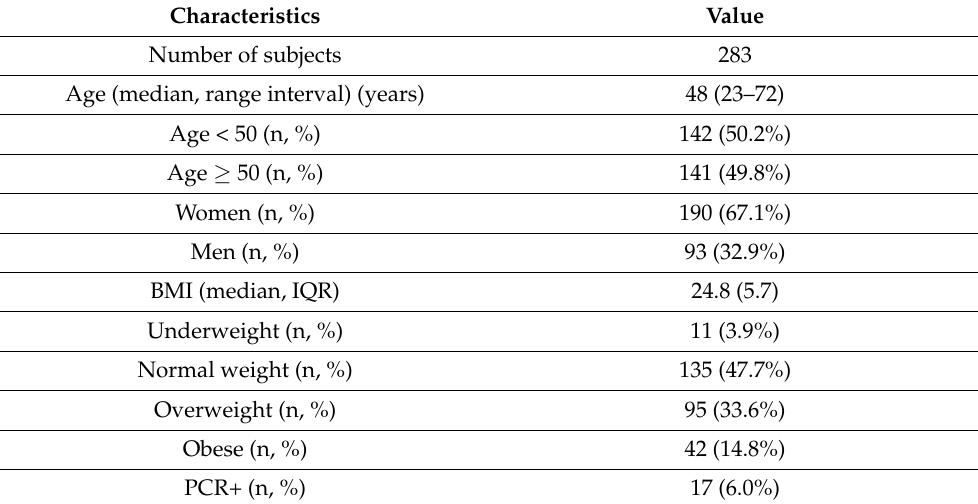
Table 1. Characteristics of individuals included in the study.